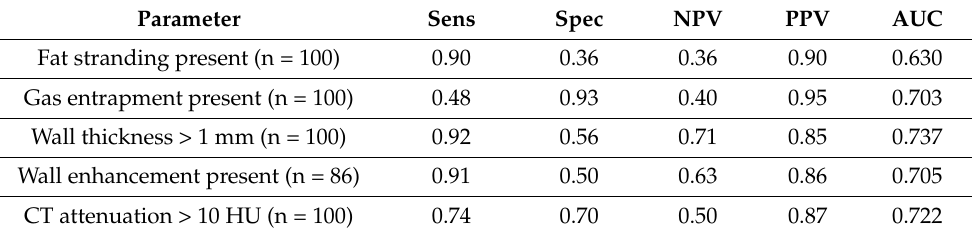
Table 3. Test characteristics for parameters to identify microorganism-containing fluid collections.